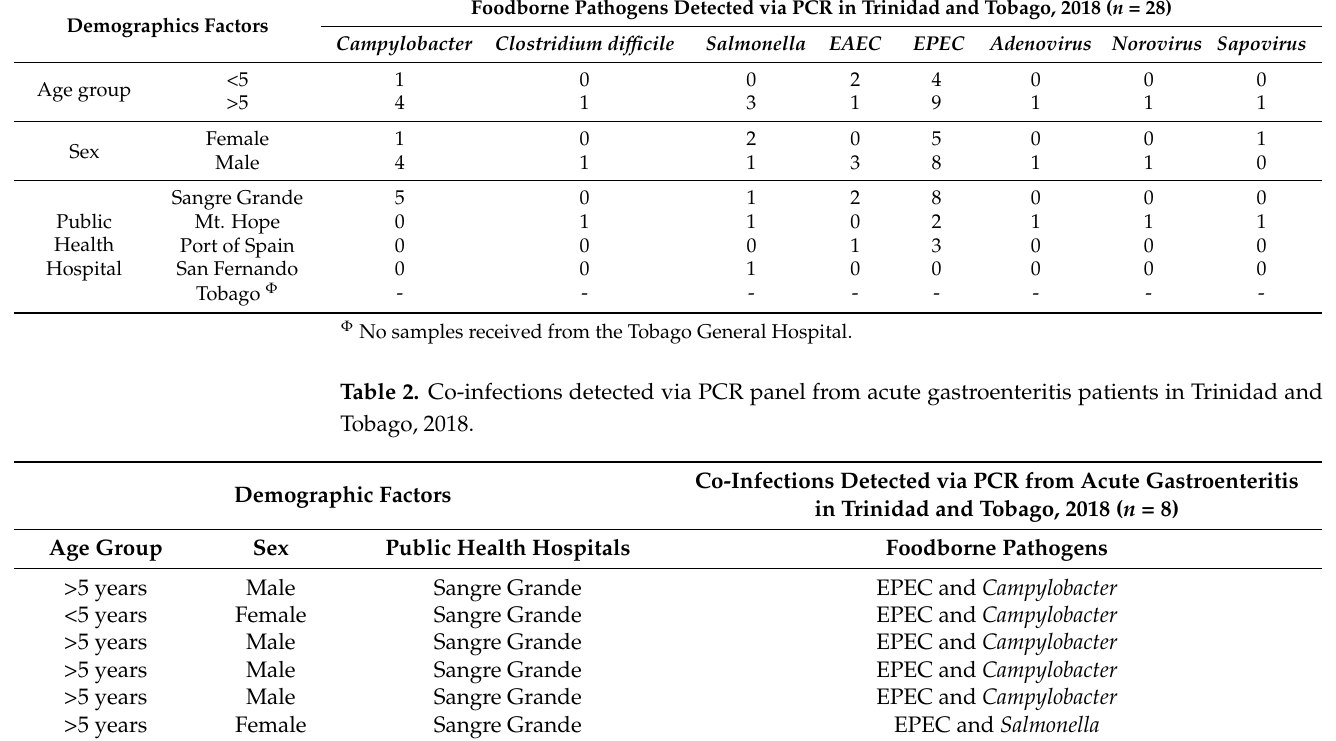
Table 1. Demographic factors associated with foodborne pathogens detected via PCR panel from acute gastroenteritis patients in Trinidad and Tobago, 2018.